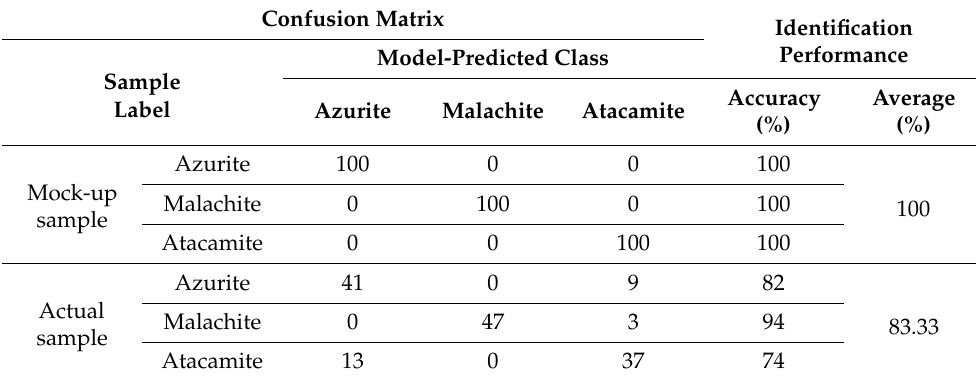
Table 3. Confusion matrix and accuracy of RF identification model for three samples.